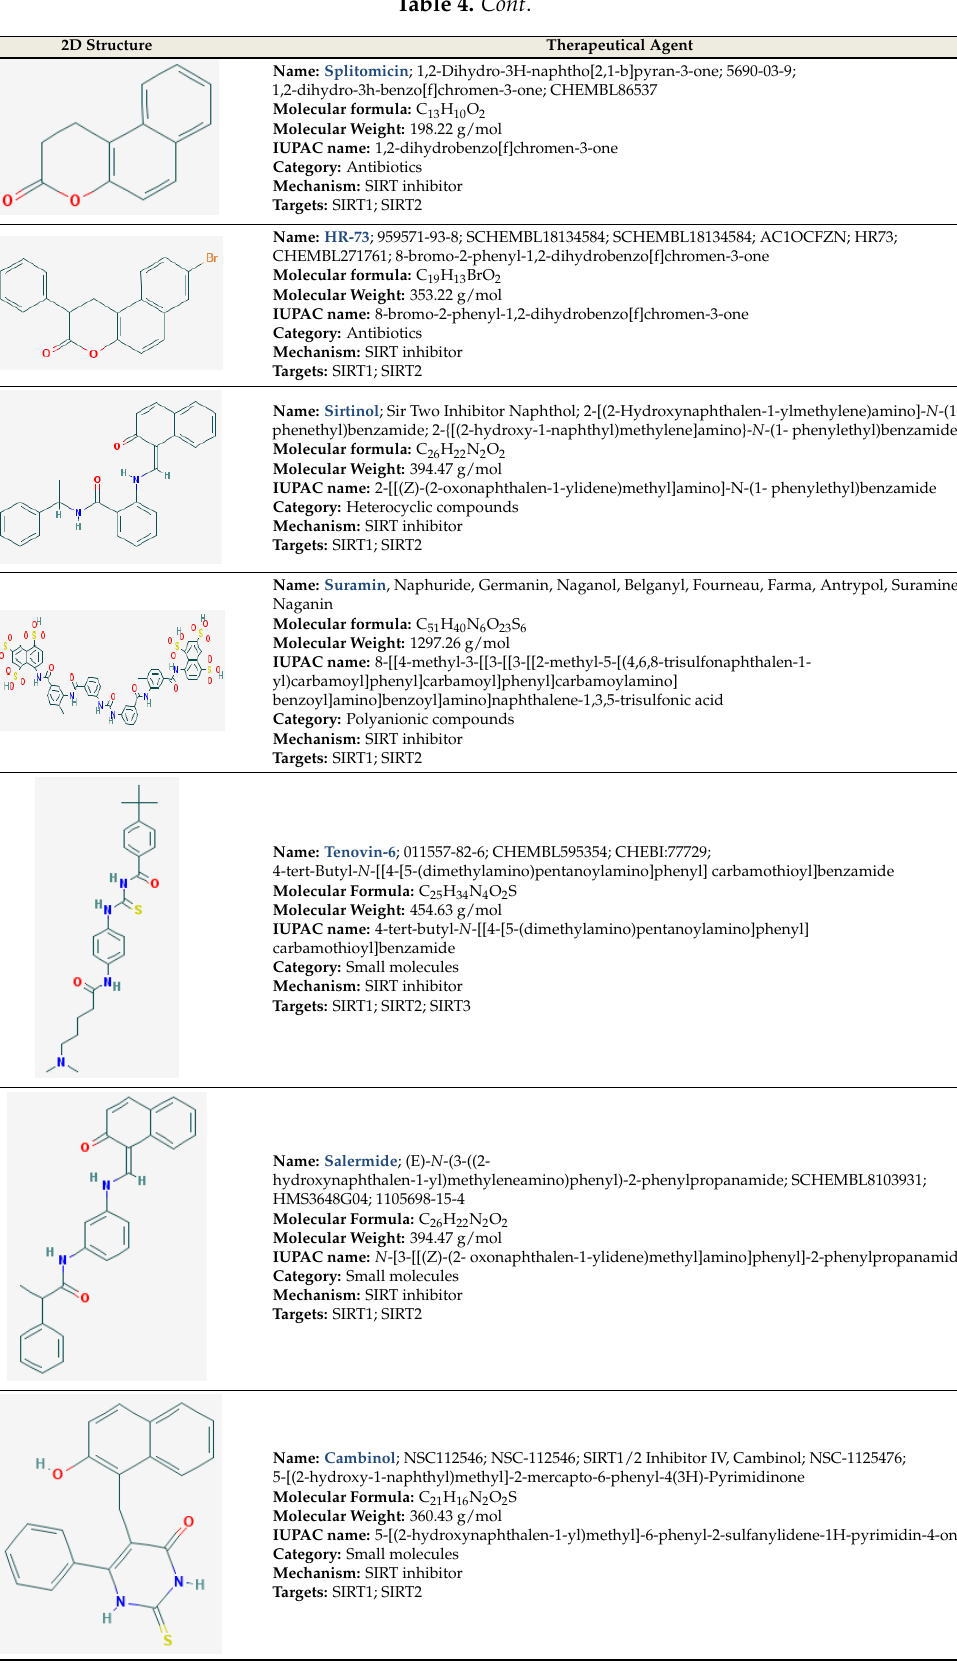
Mechanism: SIRT inhibitor Targets: SIRT1;